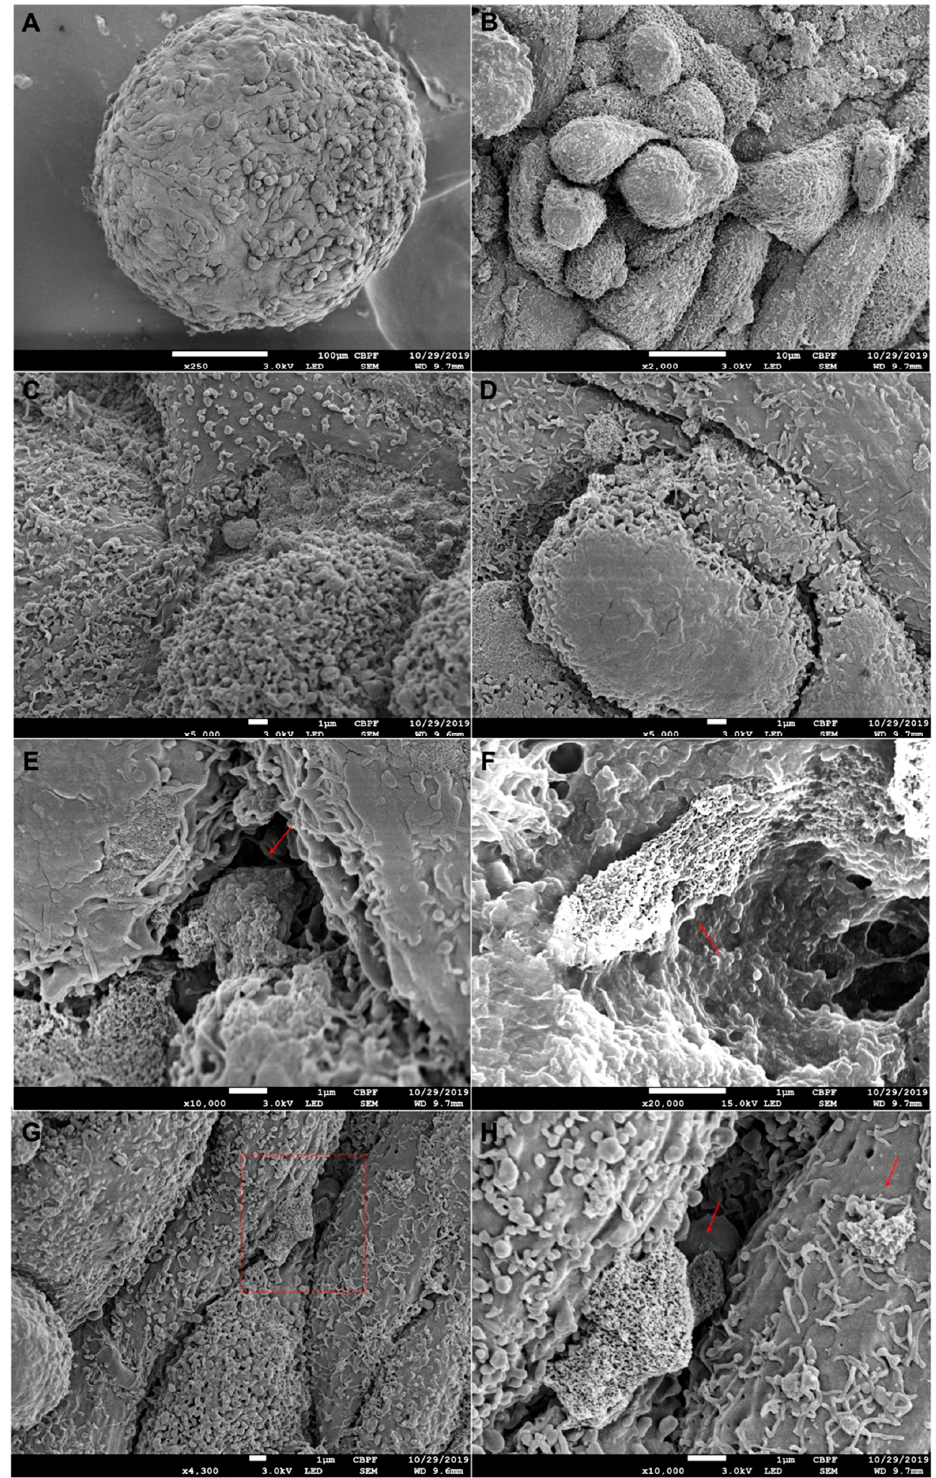
Figure 3. Electron micrographs of MG-63 osteospheres, 4 days of formation. ( A ) At 250× magnification. Higher magnification photomicrographs show cells with many microvilli and strong intercellular interaction on the aggregate surface ( B – D ). It is also possible to observe spaces between the cells and the formation of deposits on the cell surfaces that enter the aggregate, which is indicated by the red arrows in the figures ( E – G ). Figure ( H ) shows a larger magnification of the red square region in Figure 3G.